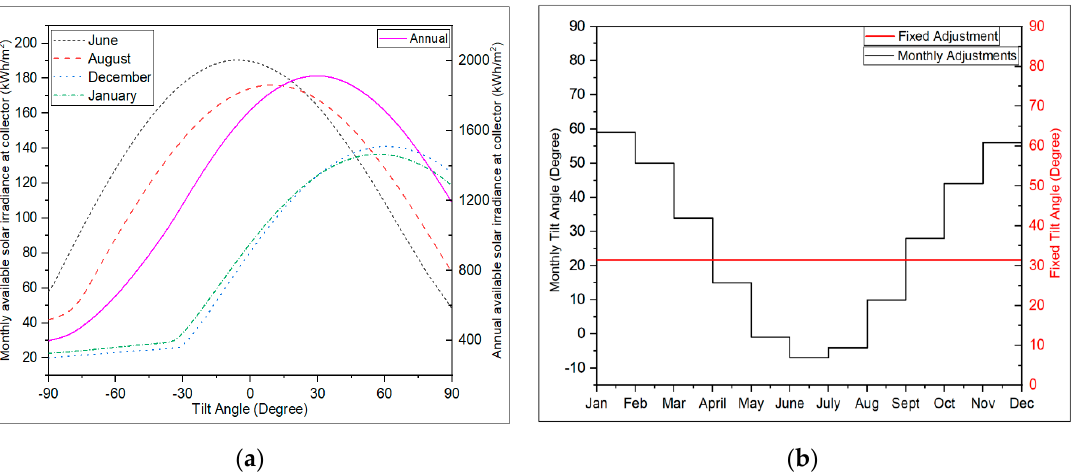
Figure 13. ( a ) Variation of solar irradiance as a function of collector tilt angle; ( b ) monthly optimized collector tilt angles.